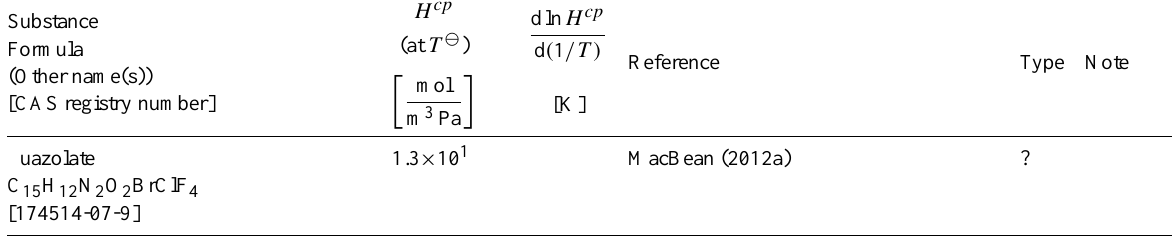
Table 6: Henry’s law constants for water as solvent